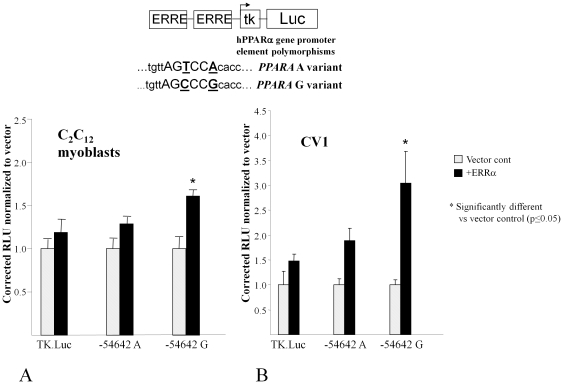

PPARA −54,642 A variant is less responsive to ERR-mediated co-activation.Mean normalized luciferase activities (±SE) in (A) C2C12 myobalst cells or (B) CV1 cells cotransfected with PPARA −54,642 A or PPARA −54,642 G promoter-reporter constructs +/− a mammalian expression vector that overexpresses ERRα as indicated. Asterisks represent significantly different transcriptional activation compared to vector control (p<0.05). Four independent trials were performed in triplicate for each cell line.